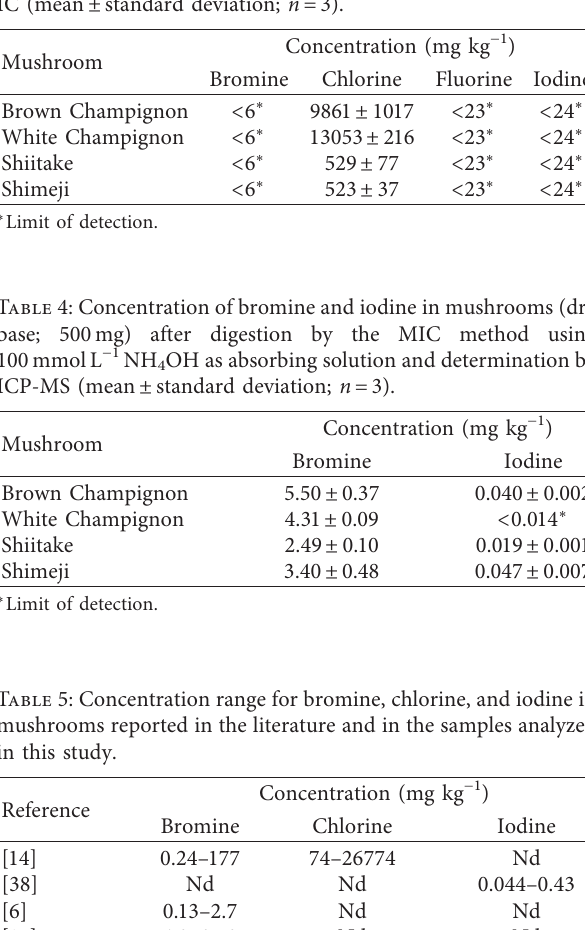
Table 3: Concentration of halogens in mushrooms (dry base;